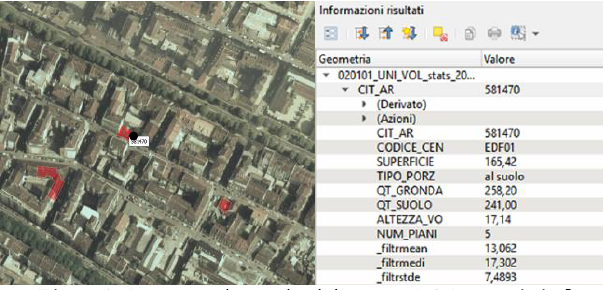
Figure 6. Correspondence check between DSMD statistical values and digital mapping of Torino, red . Volume data analysis on a sample with attribute about “ Volume height ”